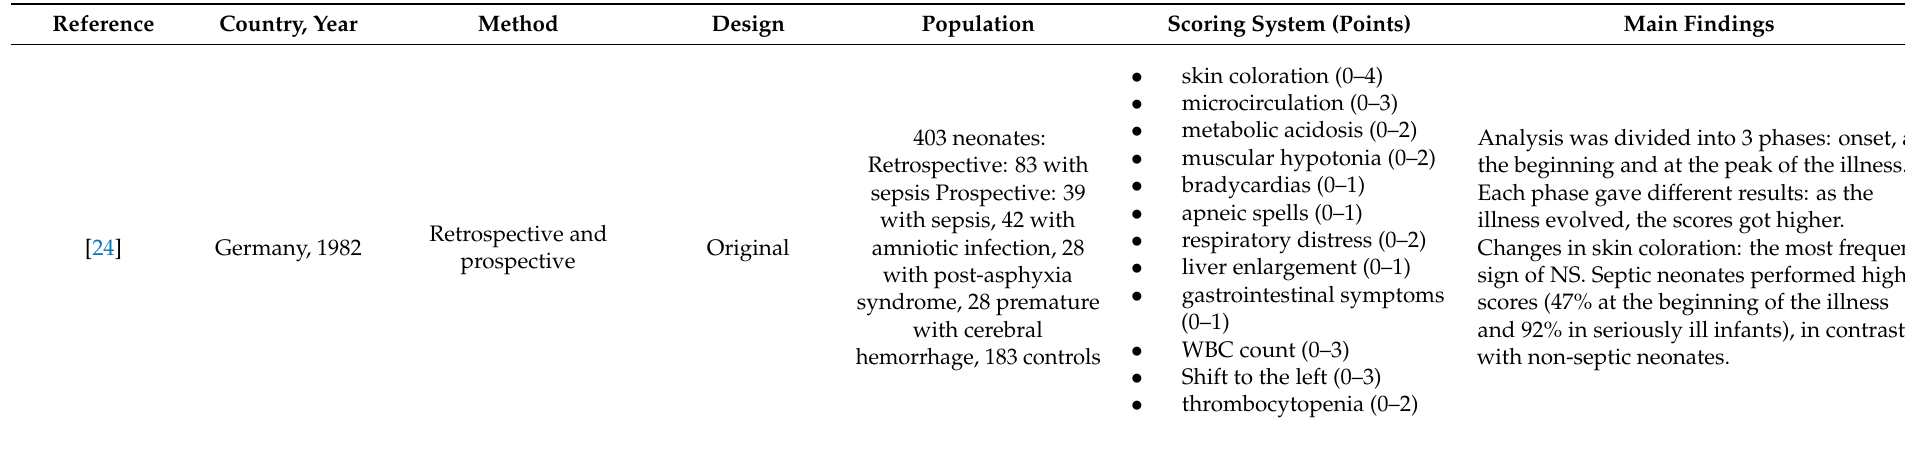
Table 3. Predictive scores for the LOS with combined